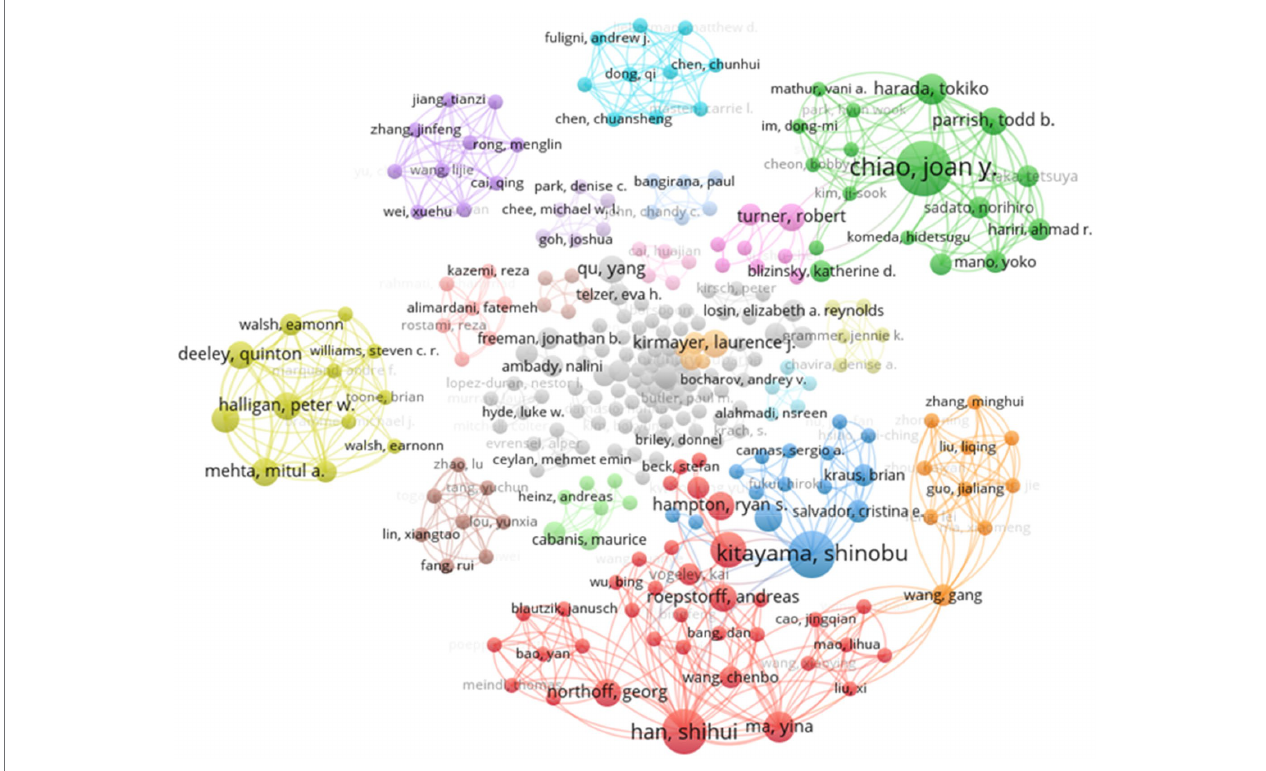
FIGURE 4 | Author collaboration